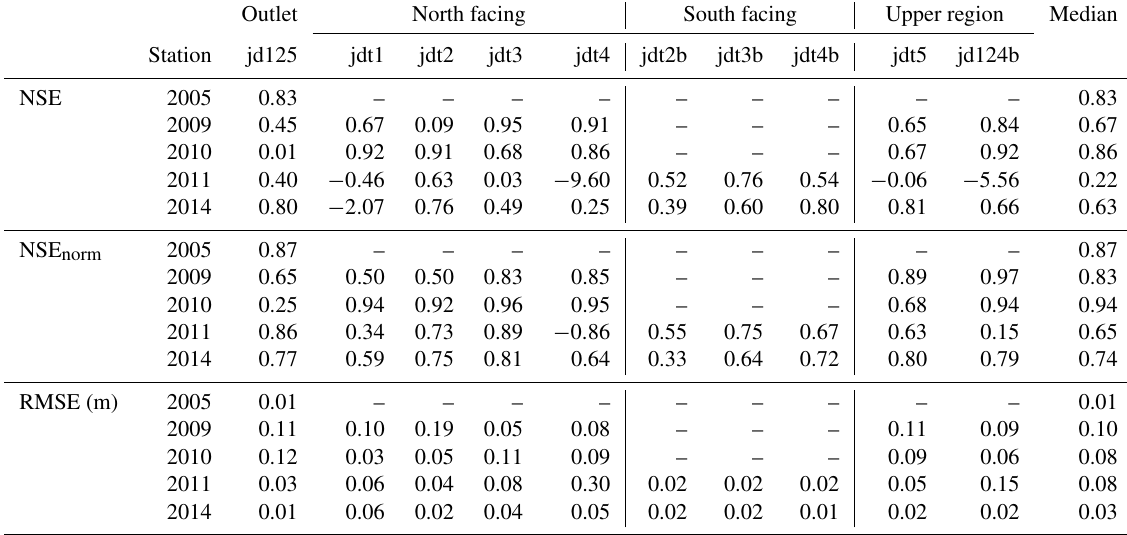
Table 2. The Nash–Sutcliffe efficiency (NSE; Nash and Sutcliffe, 1970) and root-mean-square error (RMSE) for simulated and observed snow depths at each weather station as well as the NSE for normalized ( z -transformed) snow depths (NSE norm ). Dashes (–) indicate that no observed snow depths were available in that year. See Fig. S7 in the Supplement for the time series of observed and simulated snow